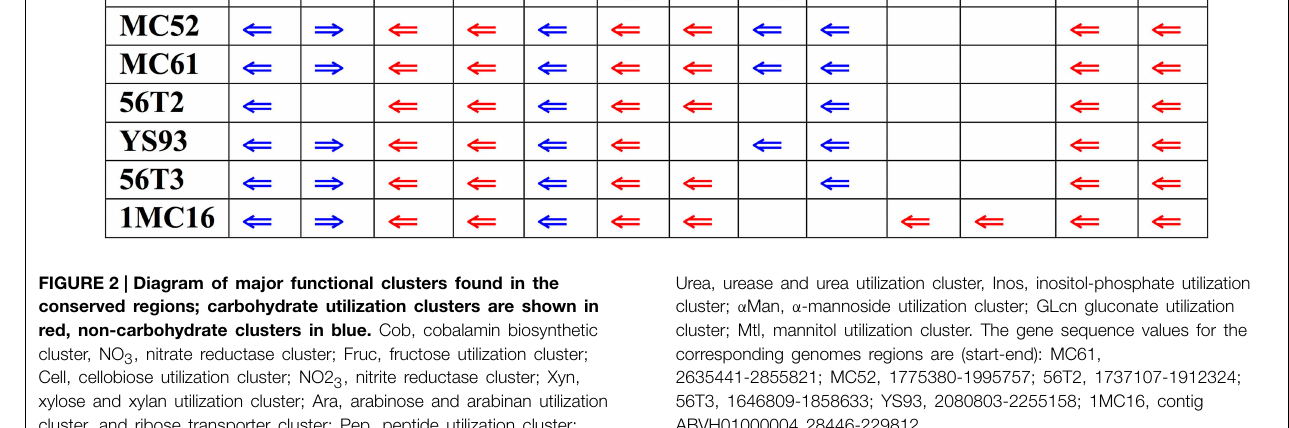
TABLE 5 | 1MC16 Inositol-phosphate metabolic